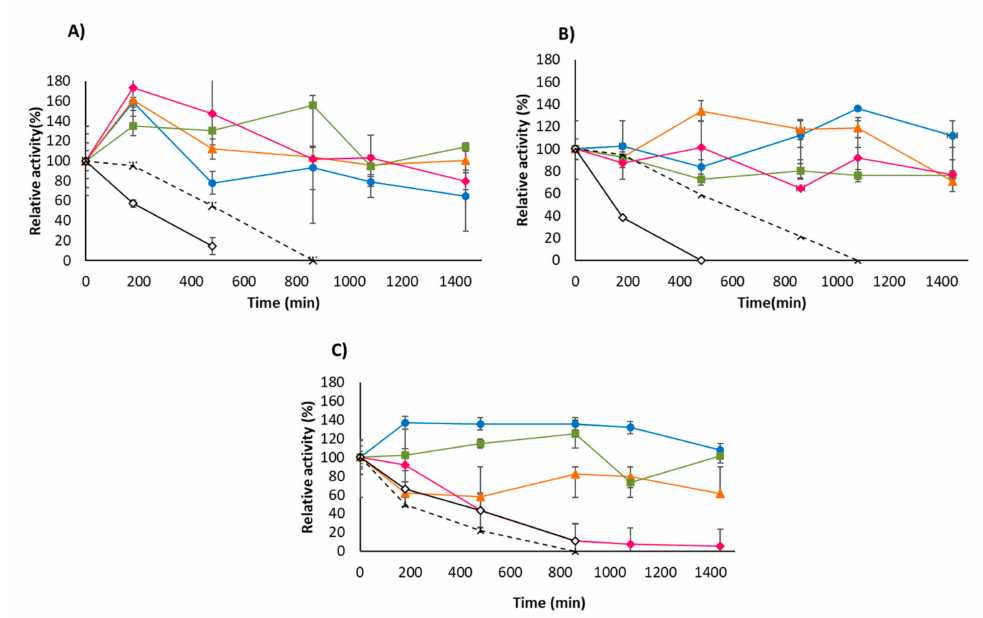
Figure 5. Thermal inactivation at pH ( A ) 5, ( B ) 7, and ( C ) 9 of different USBA-GBX-513 lipase preparations at 90 ◦ C. Empty rhombi: free USBA-GBX-513; dotted line OC-CALB; blue circles: OC-USBA-GBX-513; orange triangles: OCGLX-USBA-GBX-513; green squares: Q-Sepharose-USBA- GBX-513; pink rhombi: CNBr-